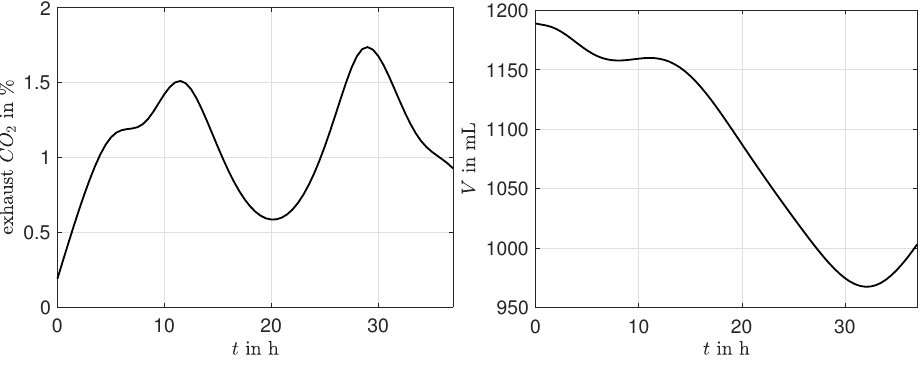
Figure A1. Assumed measurements of CO 2 and V for PHB